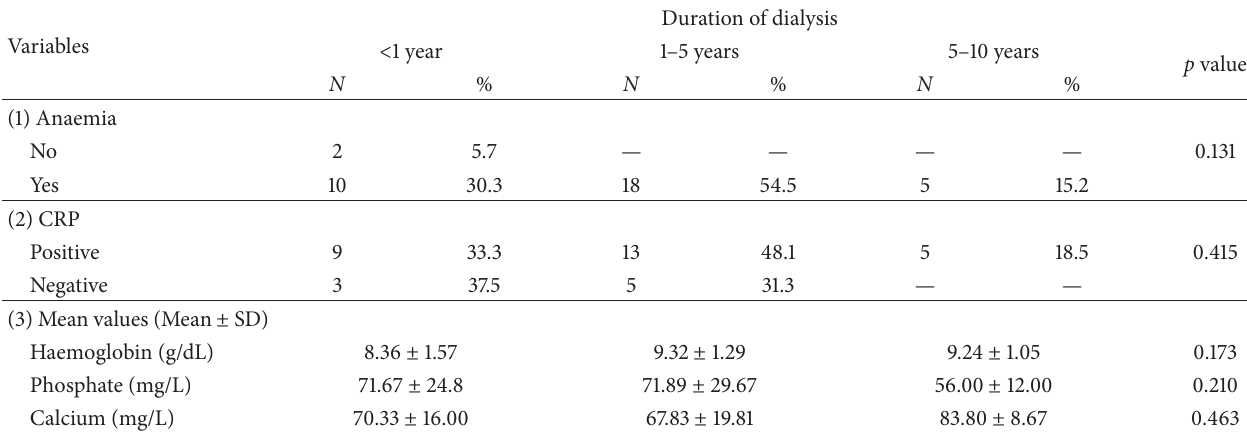
Table 4: Distribution of specific cardiovascular disease risk factors among study participants by duration of